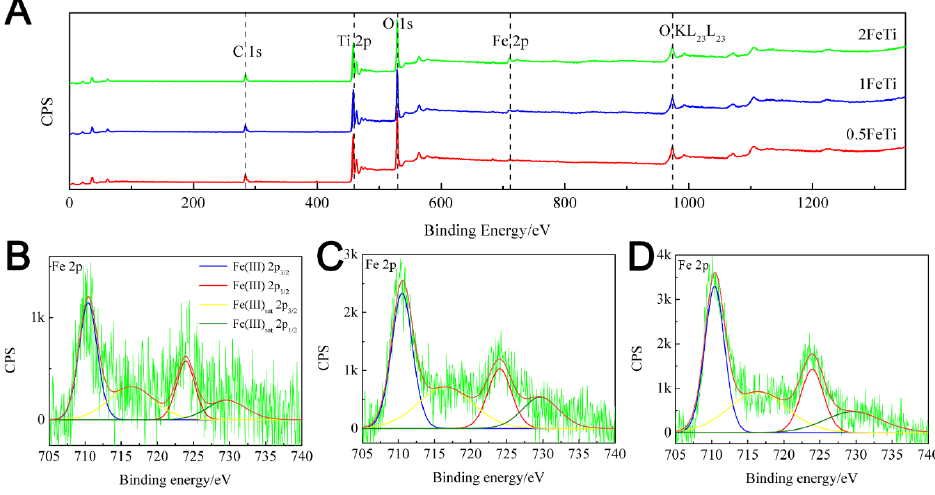
Figure 3. XPS spectra of the as-synthesized composites. ( A ) Full survey of samples; ( B ) Fe 2p region of 0.5FeTi; ( C ) Fe 2p region of 1FeTi; ( D ) Fe 2p region of 2FeTi.